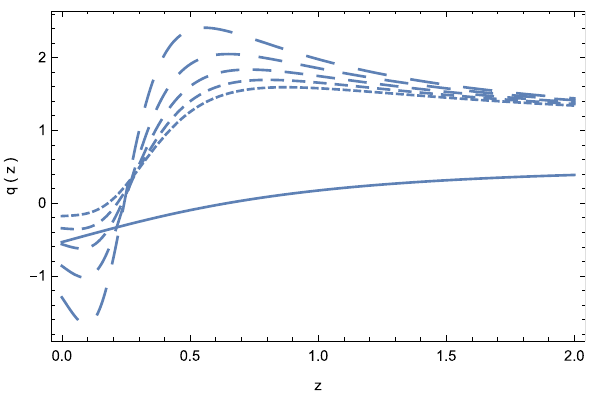
Fig. 14 Variation as a function of the redshift of the Lagrange mul- (cid:11) (cid:12) ˜ Q , ˜ T = tiplier (cid:4)( z ) for the geometry-matter coupling function F η e μ ˜ Q / 6 + ν ˜ T for M = 1 . 7, η = 6 /μ , ν = 20, and for different values of μ : μ = 1 . 7 (dotted curve), μ == 1 . 5 (short dashed curve), μ = 1 . 3 (dashed curve), μ = 1 . 1 (long dashed curve), and μ = 0 . 9 (ultra-long dashed curve). To integrate the system of cosmological evolution equa- tions we have used the initial conditions h ( 0 ) = 1, (cid:18)( 0 ) = 0 . 058, and (cid:4)( 0 ) = 0 .